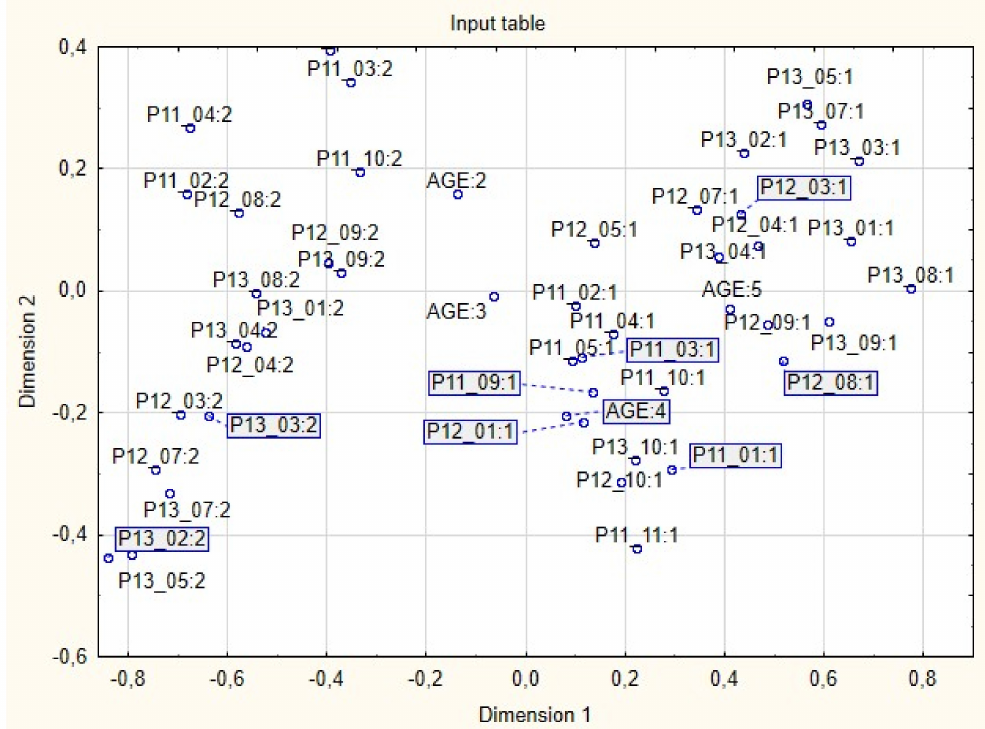
Figure 2. Two-dimensional map of perception for the age variables and subjective evaluation of the components of remuneration.